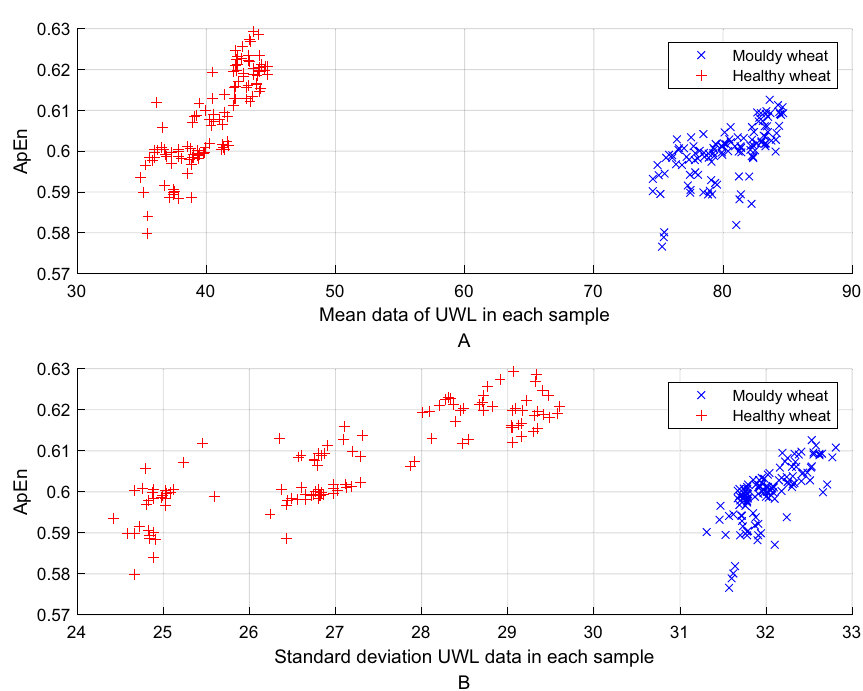
Figure 4. ApEn value of the healthy and the moldy wheat under different statistical